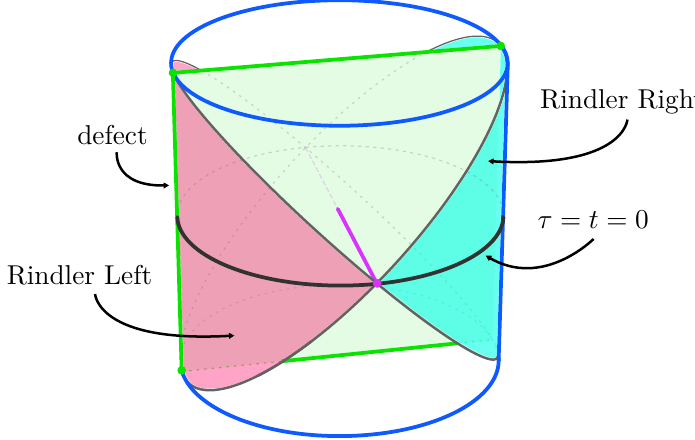
Figure 4. Our eternal black hole coupled to the CFT bath, as seen from the bulk perspective